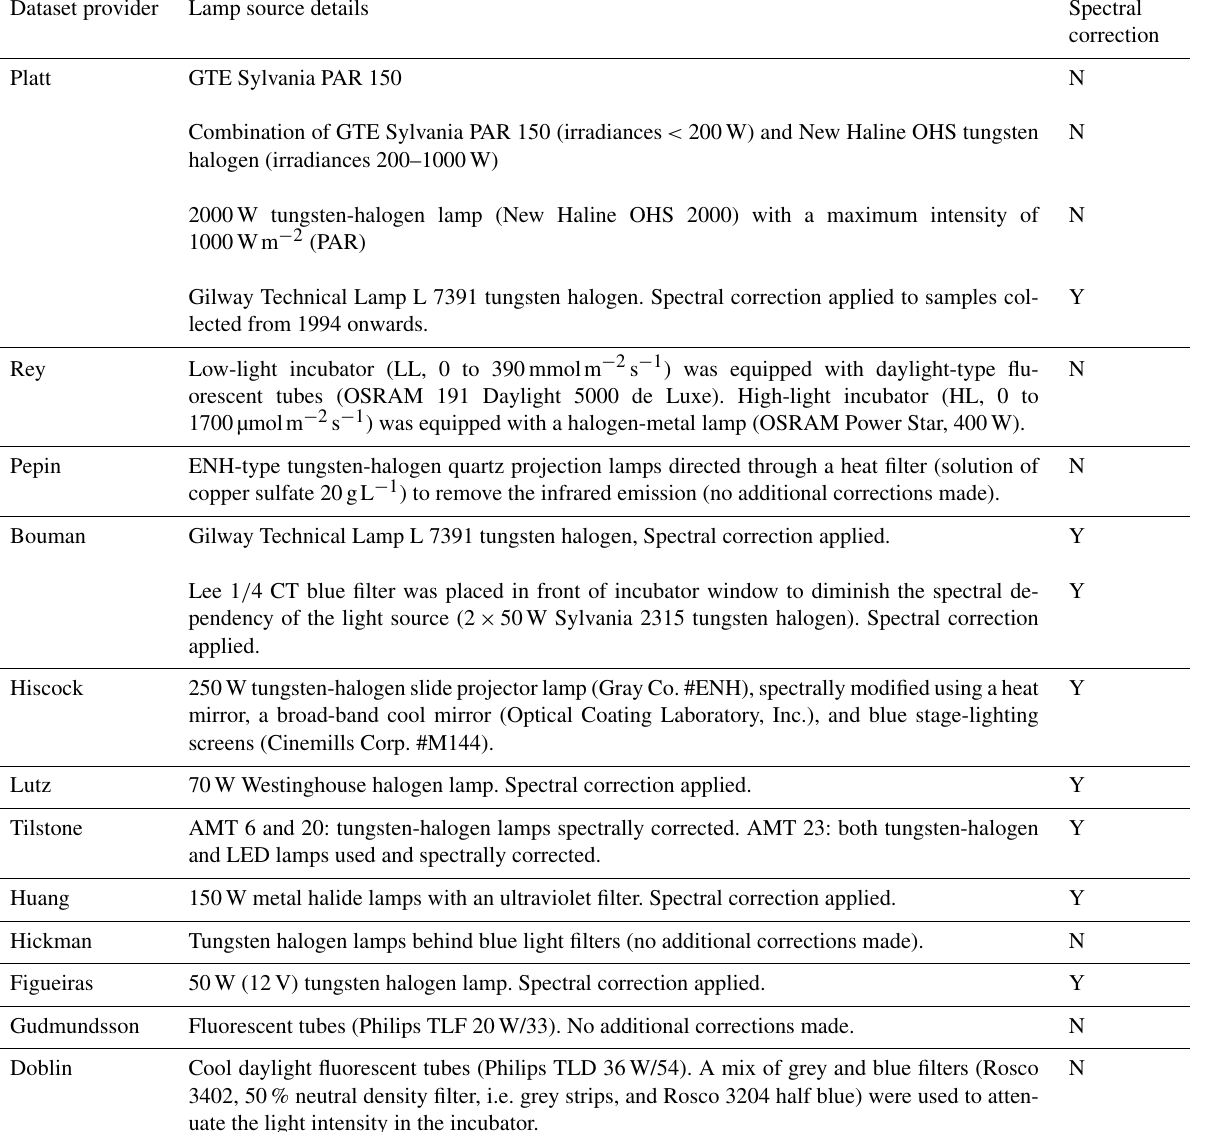
Table 4. Information on the light sources and filters used for photosynthesis–irradiance experiments for each of the data set providers. Also noted is whether the spectral correction of Kyewalyanga et al. (1997) shown in equation was applied to values of α B . Dataset provider